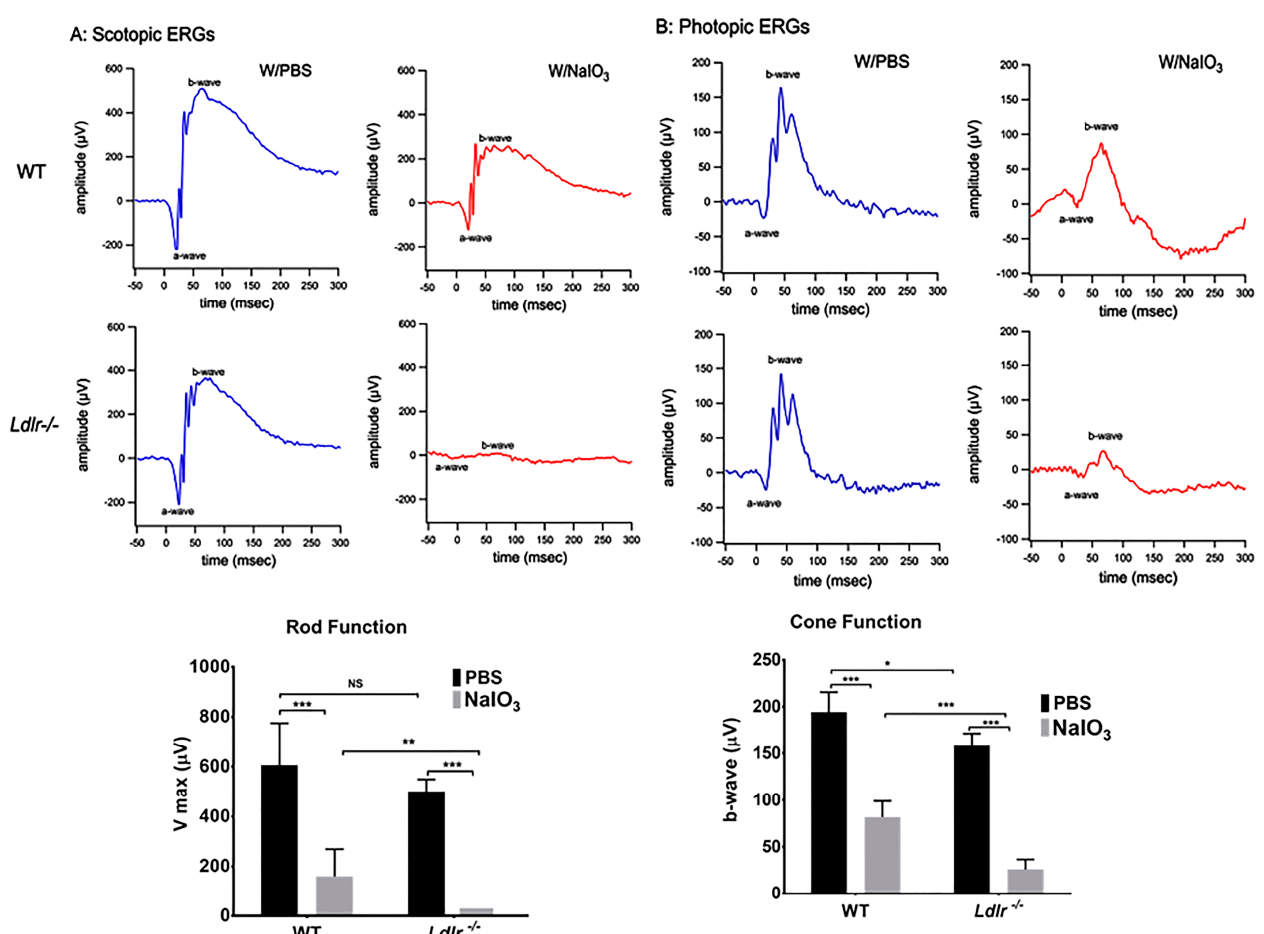
Figure 4. Effects of NaIO 3 on vision function in Ldlr -/- and WT mice. ERG was used to study retinal function, and responses to single-intensity flashes were measured under scotopic and photopic conditions. Representative scotopic ( A ) (flash intensity = 0.02 cds/m 2 ) and photopic ( B ) (flash intensity = 20.0 cds/m 2 ) waveforms for the brightest stimulus from each group are shown (upper two panels). Averages and SEM of saturated retinal response amplitudes by group are also shown (lower panels). NaIO 3 (20 mg/kg) treatment significantly reduced visual function in Ldlr -/- and WT mice, which was further compromised by Ldlr deficiency (mean ± SEM, n =5–6; NS: ns: not significant, * p < 0.05, ** p < 0.01, *** p < 0.001).